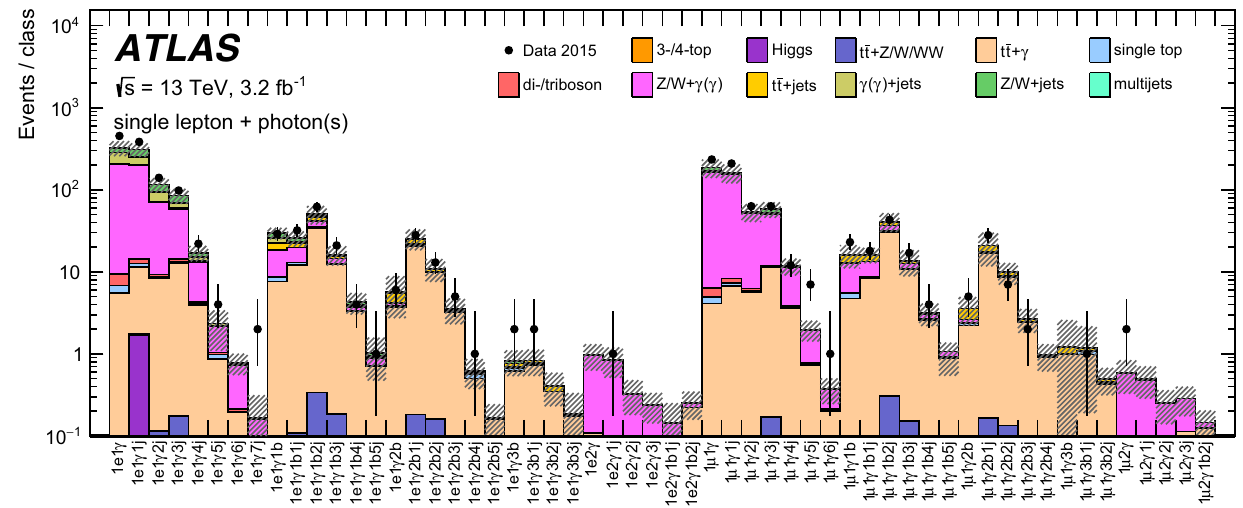
Fig. 17 The number of events in data, and for the different SM back- ground predictions considered, for classes with one lepton, at least one photon and ( b -)jets (no E miss ). The classes are labelled according to T